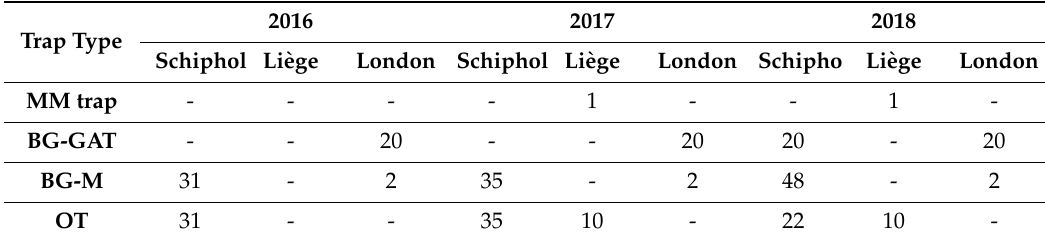
Table 1. Number of mosquito traps placed each year at the airports of Schiphol (the Netherlands), Li è ge (Belgium), and London (Heathrow and Gatwick, United Kingdom). MM Trap = Mosquito Magnet trap; BG-M = BG Mosquitaire; OT = Oviposition